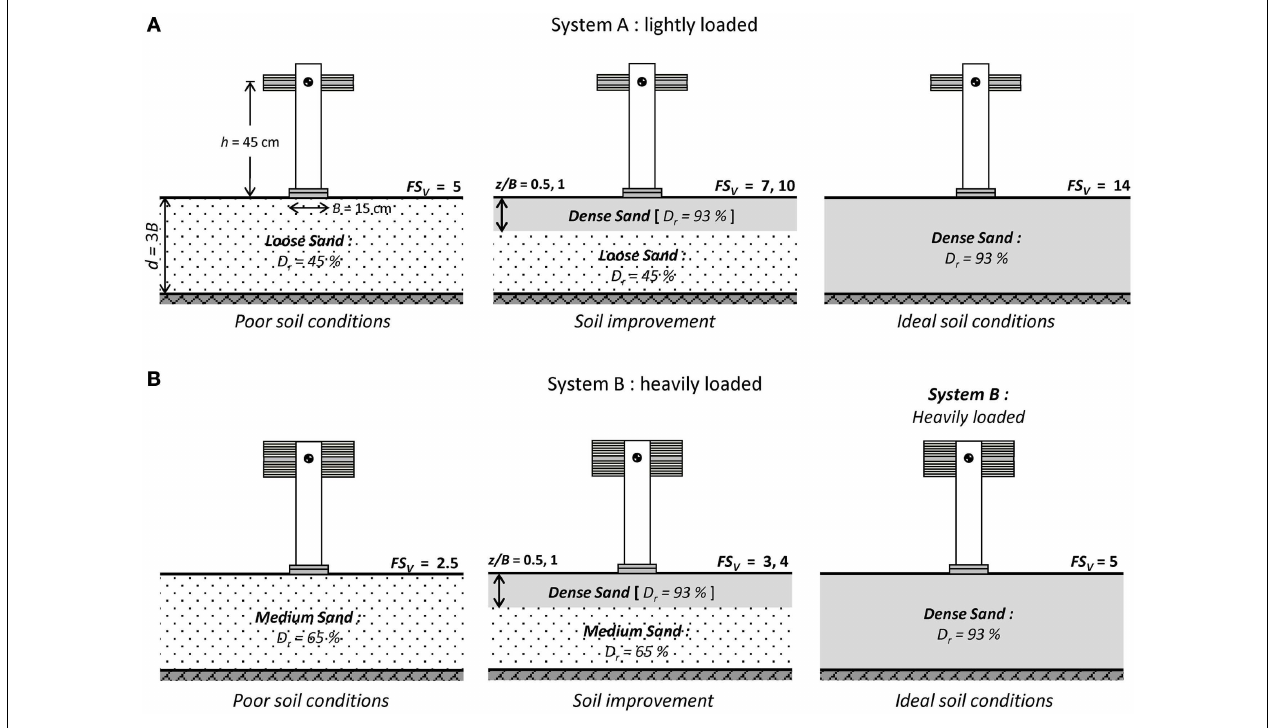
used to represent poor soil conditions, while dense sand represents the reference case of ideal soil conditions. Soil improvement is materialized with a shallow soil crust of dense sand, of varying depth (z/B =